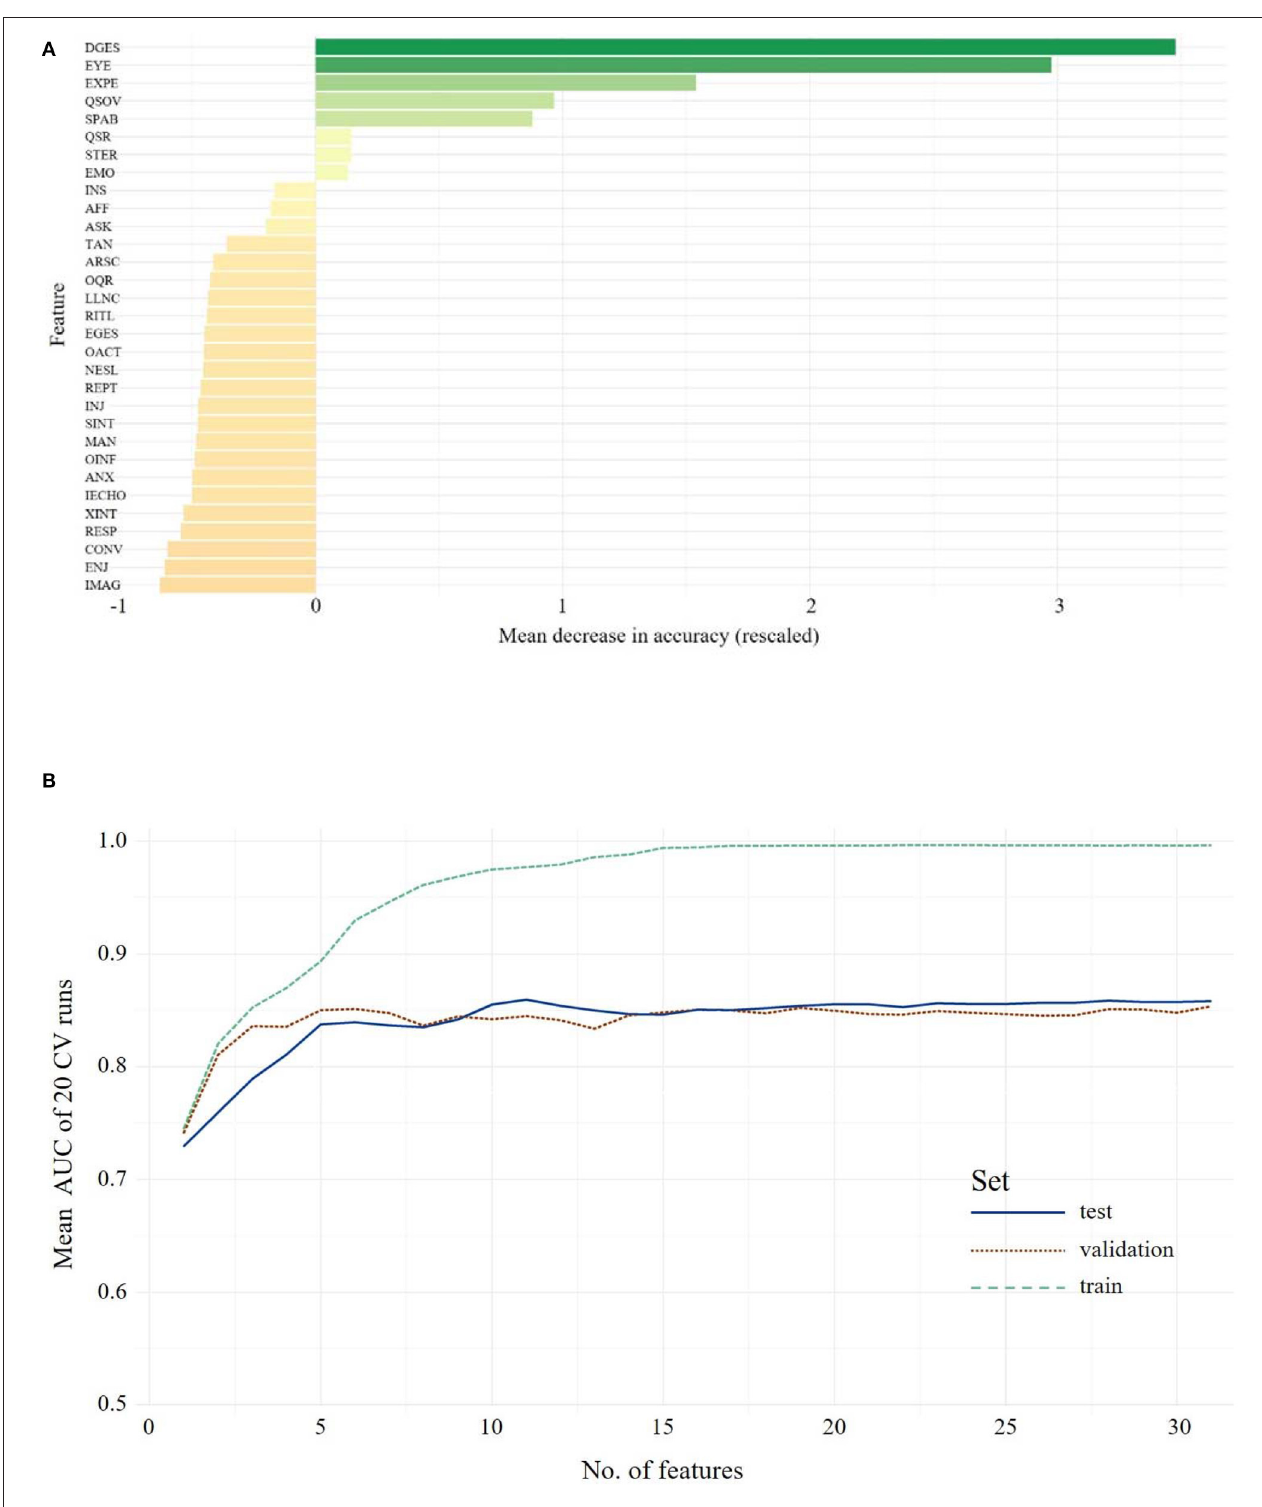
FIGURE 4 | The upper panel shows the overall ranking of feature importance for all features from ADOS data for Adolescents/Adults (A) . The figure depicts the ADOS and ADI items on the y-axis and on the x-axis its corresponding importance score, measured in mean decrease in accuracy (see text footnote 1). The lower panel (B) shows the mean AUC plotted against the number of model features from ADOS during model building (training, testing and validation of the classifiers) for Adolescents/Adults . A list of all included features and their abbreviations can be found in Supplementary Table 3 .